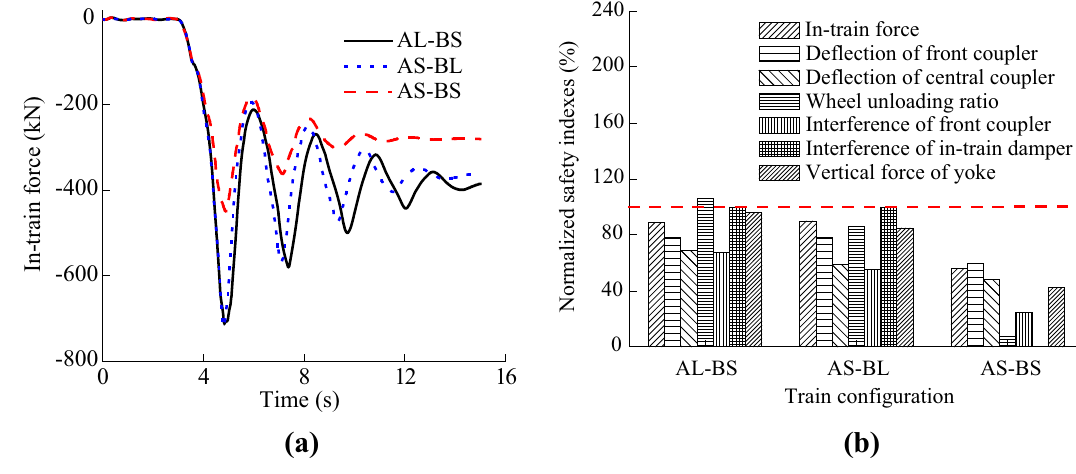
Fig. 11 Calculated results of rescue. a In-train force. b Normalized safety